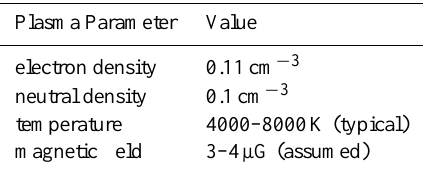
Table 2. Mean plasma parameters of Local Interstellar